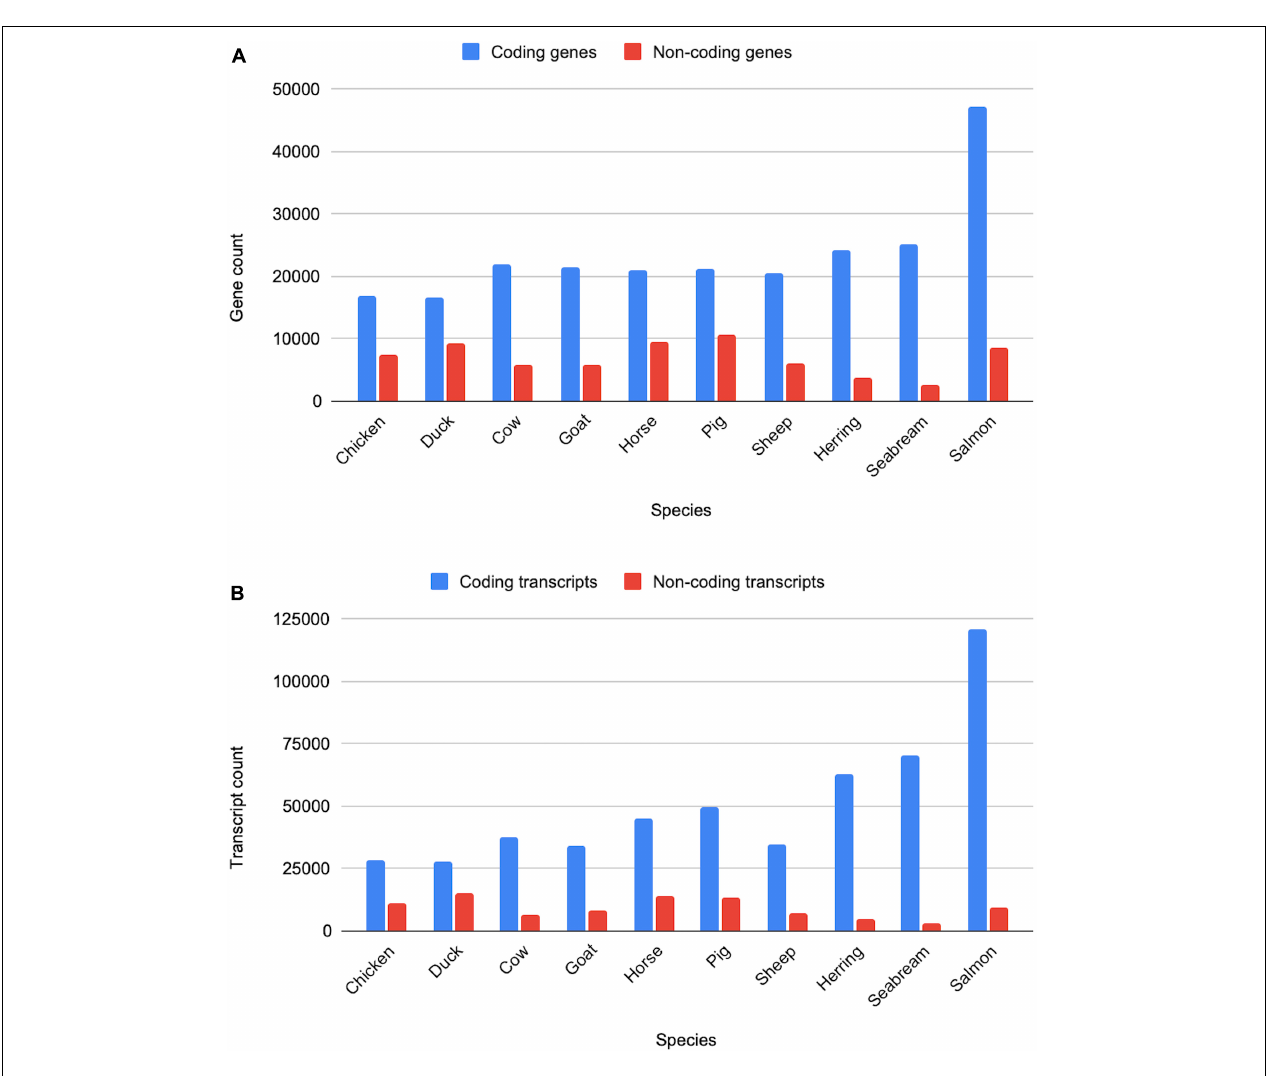
Frontiers in Genetics |